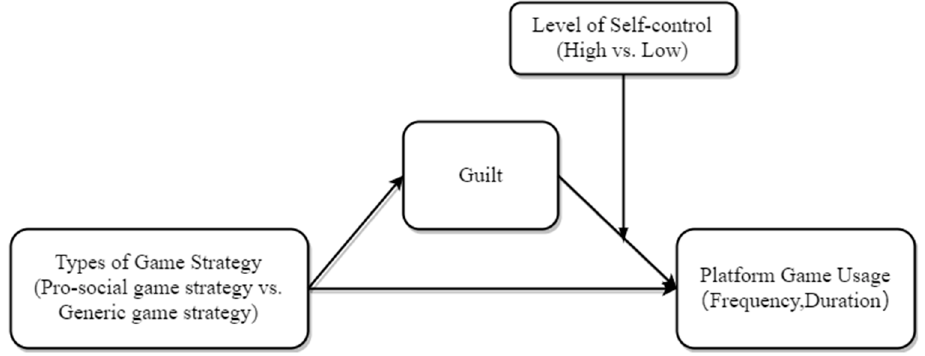
Figure 1. Concept model.